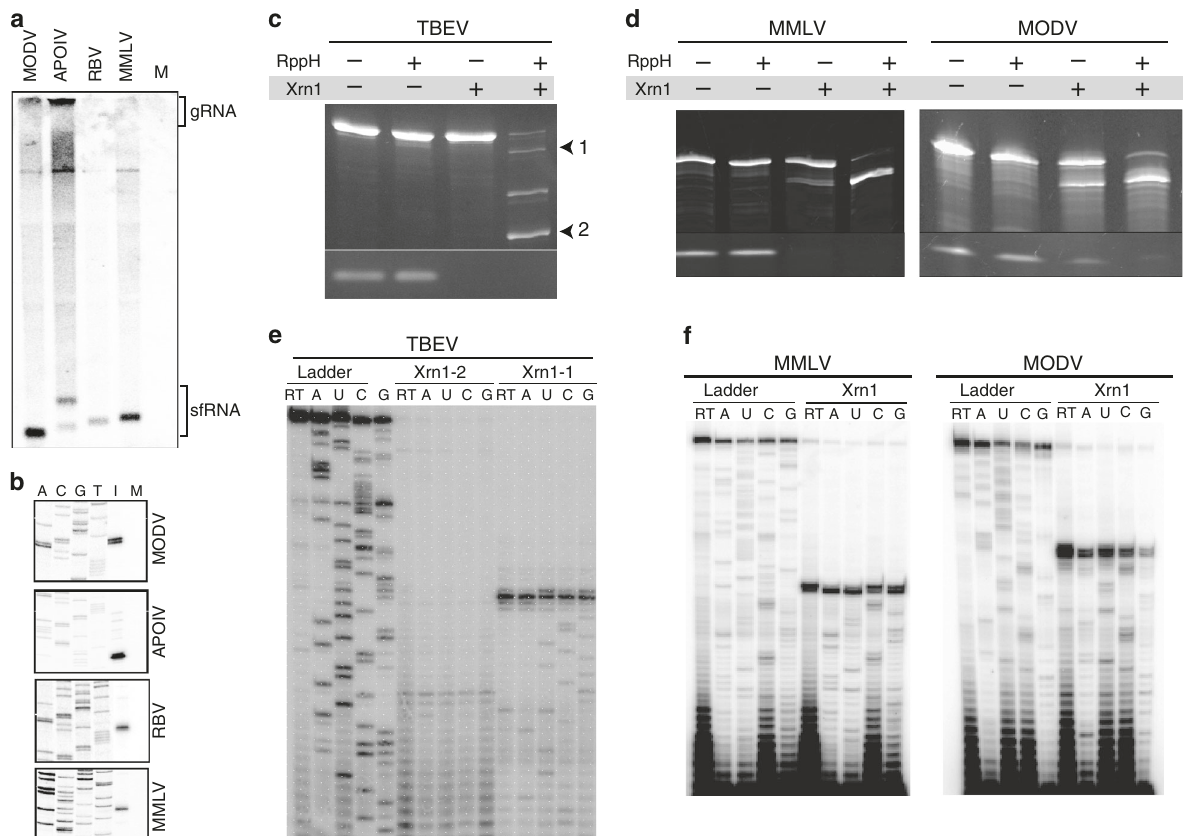
Fig. 4 Examination of sfRNAs and direct Xrn1 resistance in TBFVs and some NKVFVs. a Northern blot analysis of total RNA from BHK-21J cells infected with various viruses, using a probe of the viral 3 ′ -UTR. M = mock infected. b Reverse transcription mapping of the 5 ′ -end of the sfRNAs from a . M = mock infected, I = infected. c In vitro Xrn1 resistance assay with the 3 ′ -UTR of TBEV. RppH = RNA 5 ′ Pyrophosphohydrolase (RppH). 1 and 2 denote two Xrn1- resistant products. d Xrn1 resistance assay with the 3 ′ -UTRs of MMLV and MODV. e Reverse transcription mapping of the Xrn1 halt sites in the 3 ′ -UTR of TBEV. f Reverse transcription mapping of the Xrn1 halt sites in the 3 ′ -UTR of MMLV and MODV. Accession numbers for RNA sequences used in c – f : TBEV, NC_001672; MMLV, MC_004119; MODV, NC_003635. Gels are representative of greater than three independent